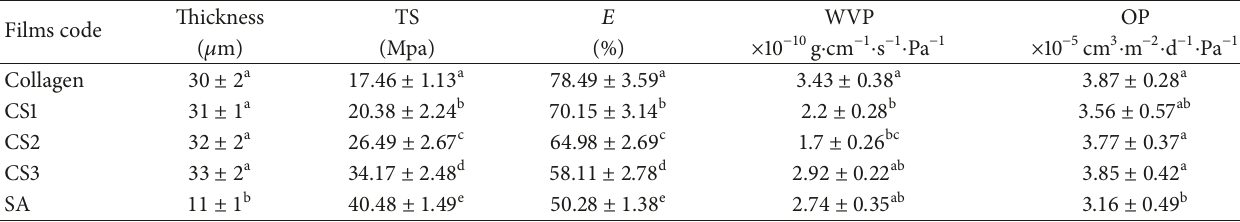
Table 2: Collagen-sodium alginate films properties: tensile strength (TS), elongation at break ( 𝐸 ), water vapor permeability (WVP), and oxygen permeability